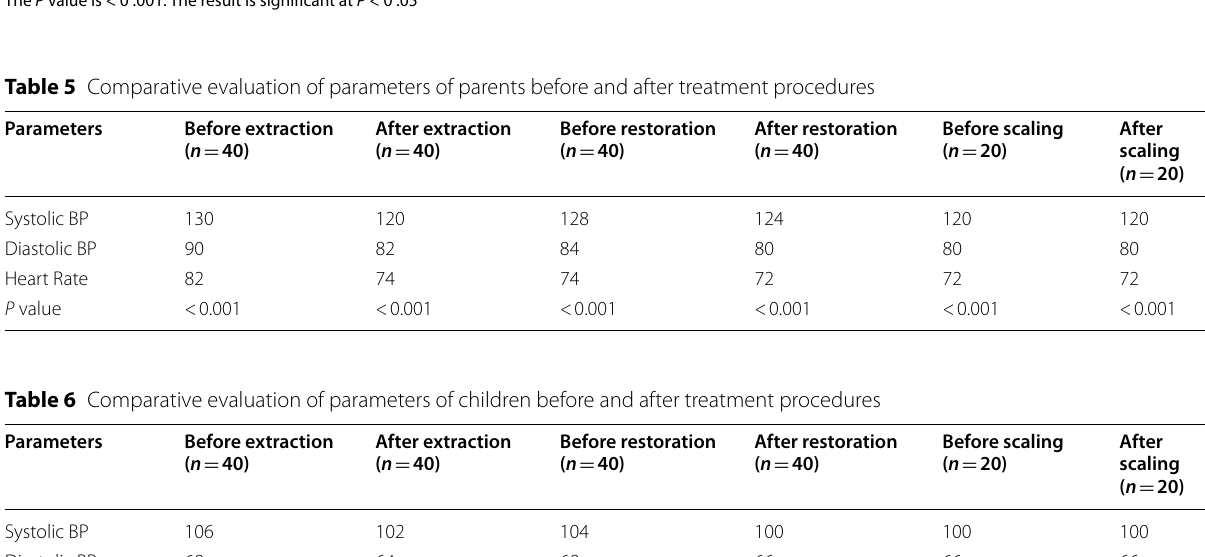
The P value is < 0 .001. The result is significant at P < 0